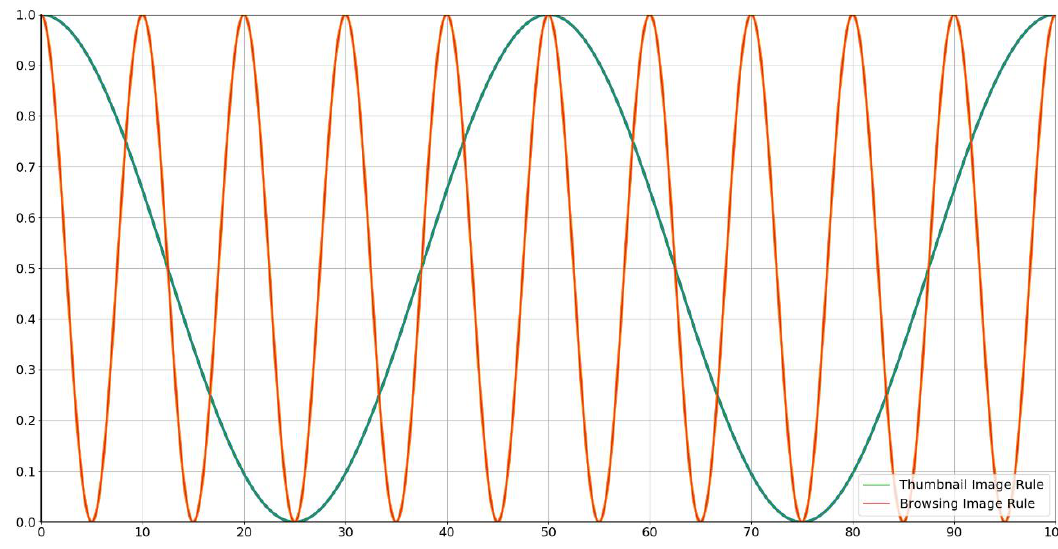
Figure 5. Diagram of the fusion-evaluation rules for the composite neural network.